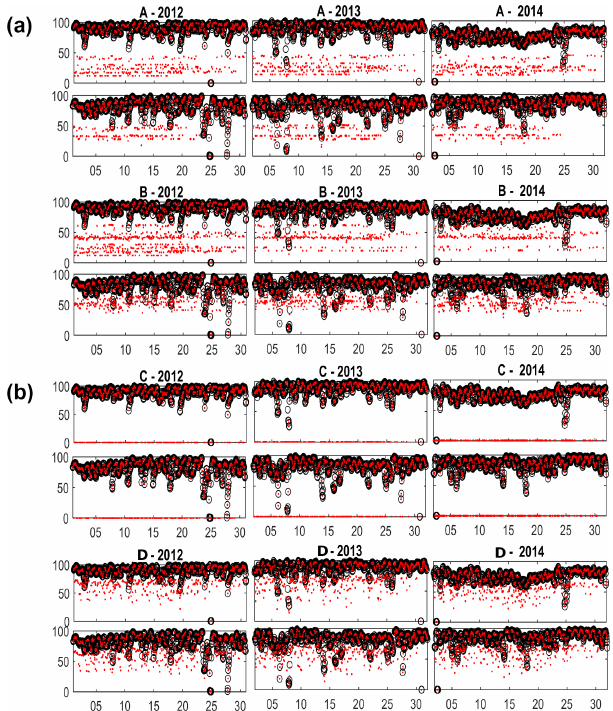
Figure 3. Percentage of spatial coverage for each time step and ex- periment. Higer data are shown in the upper panels and Matxitxako data in the lower panels in all cases. Black circles represent the per- centage of good data for the original fields. Red dots denote the percentage of good data for each experiment. The x axis is the time step of the time series for April 2012, April 2013 and April